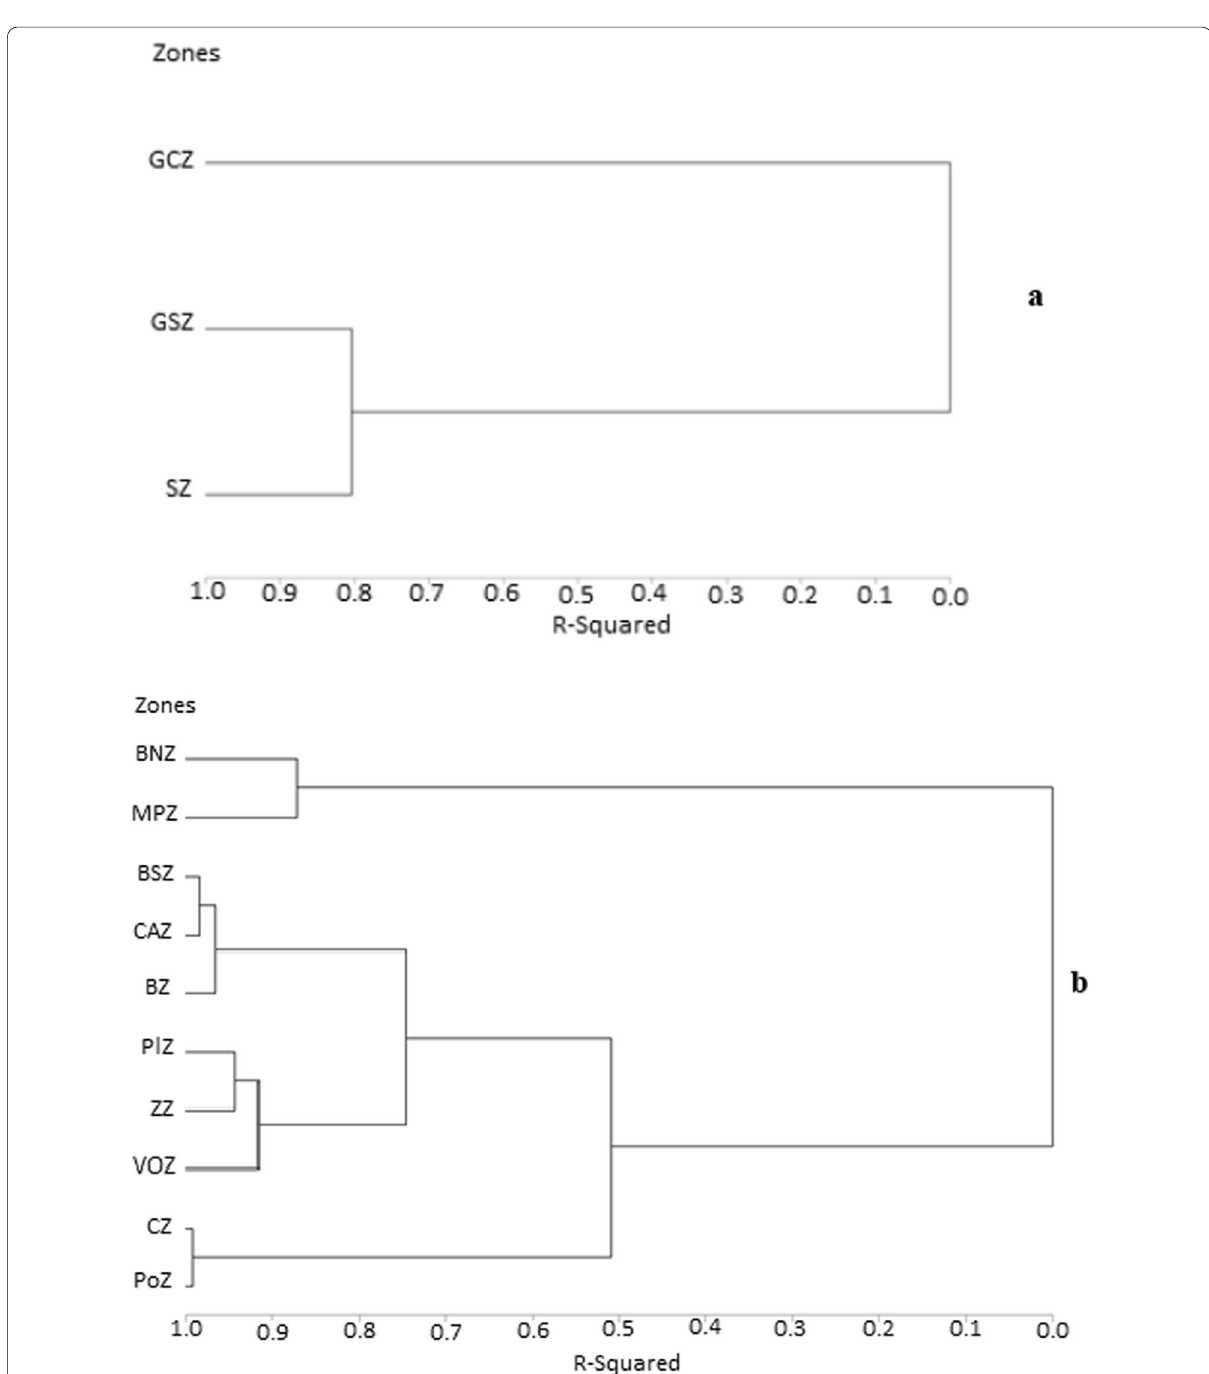
Fig. 4 Clusterdness of goat population in Benin based on Mahalanobis distance. a Representation based on vegetation zones model; GCZ Guineo-Congolese zone, GSZ Guineo-Sudanian zone, SZ Sudanian zone. b Representation based on phytogeographic zones model; MPZ Mekrou-Pendjari zone, CAZ Chaîne Atacora zone, BNZ Borgou-Nord zone, BSZ Borgou-Sud zone, BZ Bassila zone, CZ Coastal zone, PoZ Pobe zone, PlZ Plateau zone, VOZ Oueme Valley zone, ZZ Zou